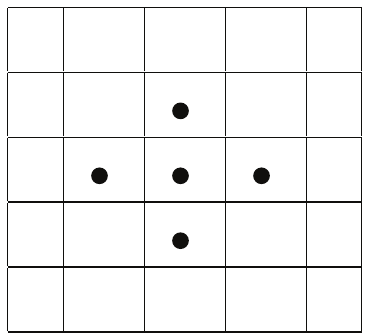
Figure 4: Von Neumann neighborhood structure for two-dimen- sional